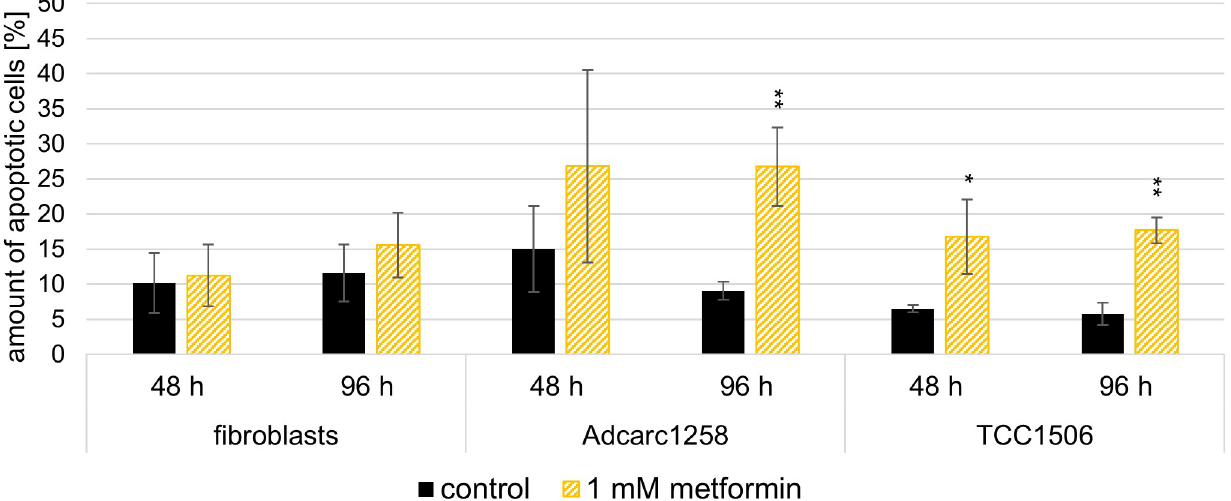
Fig 6. Apoptosis induction in fibroblasts, Adcarc1258, and TCC1506 after exposure to 1 mM metformin compared to an untreated control of the respective cell line over 48 and 96 h. Means and standard deviation are displayed, n = 3. Black asterisks: significant difference between the respective untreated control and treatment with 1 mM metformin. Significance is set at p � < 0.05, p �� < 0.01 and p ��� < 0.001, respectively. https://doi.org/10.1371/journal.pone.0257403.g006 TCC1506 was decreased compared with cell-free control. This effect was further observed after 48 h in Adcarc1258, while the metformin concentrations in the medium incubated with or without TCC1506 cells did not differ after 48 h (Fig 8C). The metformin content measured after 12 h and 24 h in the cell pellet of the TCC1506 was just above the LLOQ of the mobile phase and increased after 48 h exposure time. Adcarc1258 only achieved metformin contents in the cell pellet in the area of the LLOQ of the mobile phase after 48 h exposure time.